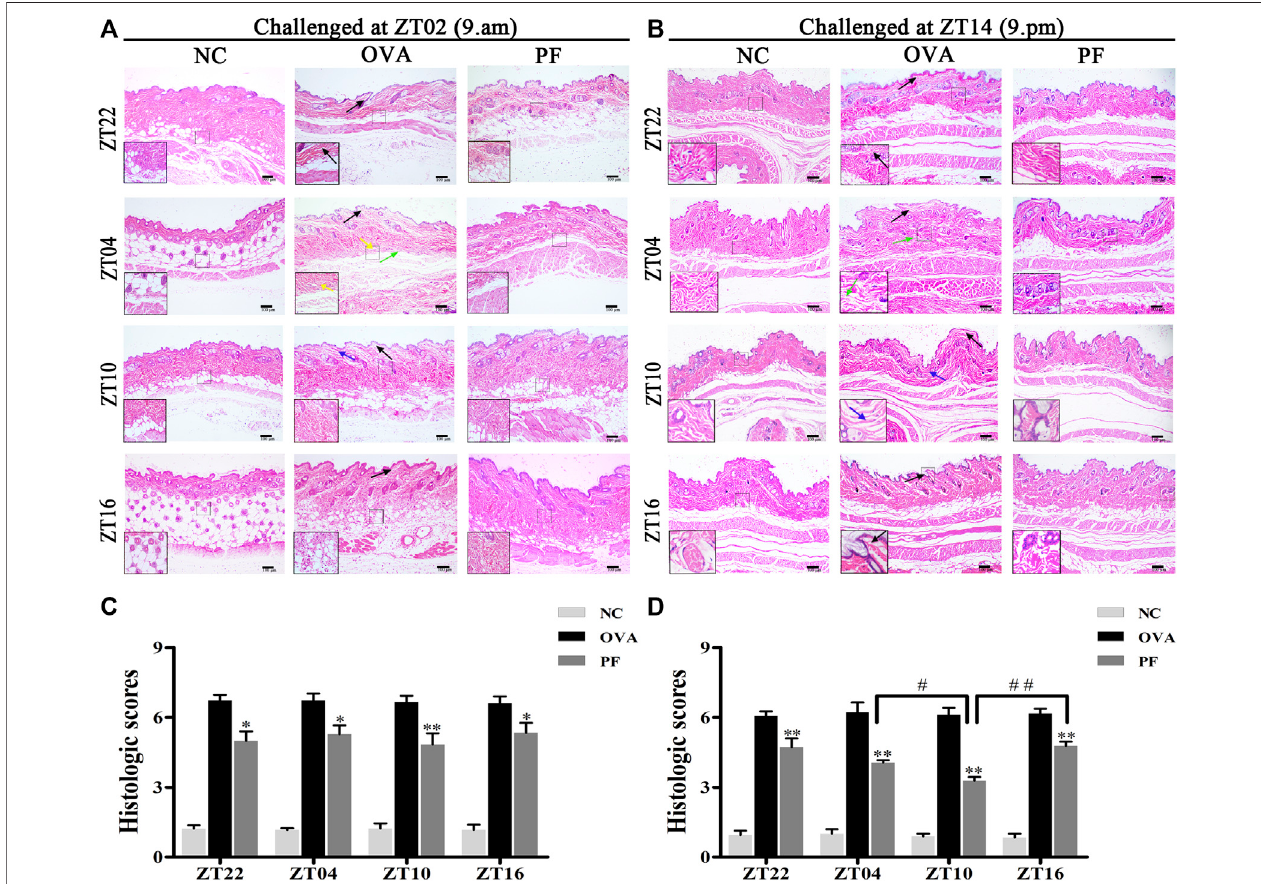
FIGURE 2 | Effect of PF treatment on histopathological features (A,B) and histologic scores (C,D ) in OVA/aluminium hydroxide-induced urticaria-like mice. Representative images of hematoxylin and eosin staining in the dorsal skin. BALB/c mice in the NC group, showing normal architecture. OVA-treated urticaria-like mice showed obvious edema in the upper dermis (black arrows), widening of collagen fi ber bundles (blue arrows), with telangiectasia (green arrows), and in fl ammatory cell in fi ltration (yellowarrows).PFtreatment, especially atZT10, improved thewheal conditions. Themagni fi cationwere × 100and 400 × .NC groupshavenotedlessor evenno edema, telangiectasia, or in fl ammatorycell in fi ltration, OVA groups displayed increasedhistologic scores, while PF induced signi fi cantinhibition ofthehistologic scores. *p < 0.05, ** p < 0.01 versus OVA mice at the same time points. # p < 0.05, # # p < 0.01 represents the comparison of PF ZT10 versus the other three PF indicated time